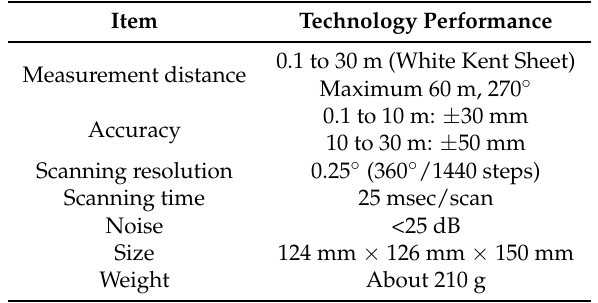
Table 2. The technology performance of LRFs used in our experiment.